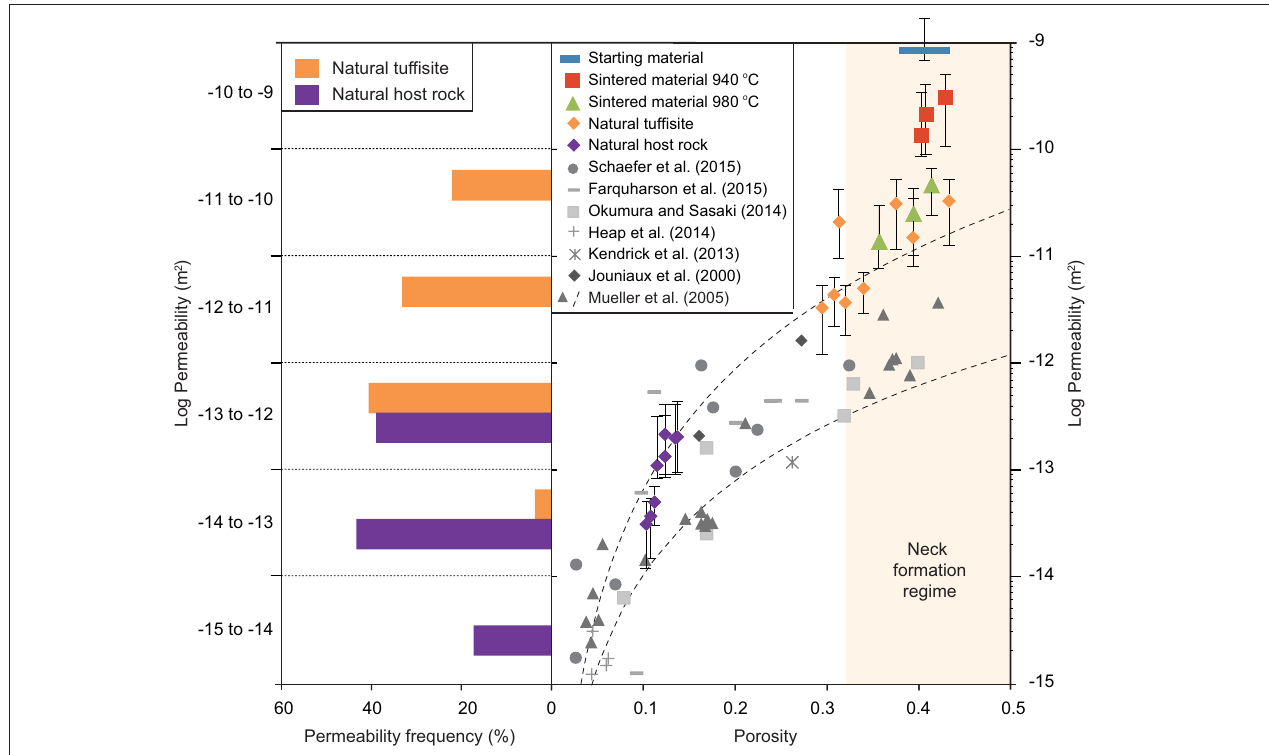
FIGURE 7 | Physical attributes of natural tuffisites, their host rocks and the crushed and sintered analogs: On the left, the permeability distribution (%) for natural materials, calculated from 23 host rock and 27 tuffisite vein permeability measurements made using the TinyPerm II minipermeameter. Following these measurements, cores of 5mm (diameter) and 3–7mm (height) were made from eight locations in the host rock and eight locations in the tuffisites to measure corresponding porosity using a He-pycnometer. All data is presented in Table 1 . On the right, this porosity and permeability relationship for the eight samples of both the natural host rock and tuffisite veins are compared to the crushed dome material and sintered tuffisite analogs from 940 to 980 ◦ C (data in Table 3 ). This is compared to porosity—permeability measurements on other lavas from Volcán de Colima (Kendrick et al., 2013; Farquharson et al., 2015) and to lavas from elsewhere ranging from basalt (Pacaya; Schaefer et al., 2015) to dacite (Mount Unzen; Mueller et al., 2005) rhyolite (Mount Meagre; Heap et al., 2014a) and in addition it is compared to the results of compaction experiments on chips of rhyolite lava (Okumura and Sasaki, 2014) and overlain by the porosity–permeability relationship for effusive lava given by Mueller et al. (2005). The plot shows the region in which the neck-formation regime is active, i.e., the region in which sintering materials plot, but where they do not follow the anticipated porosity–permeability trend for lavas. Error on permeability measurements is quoted by New England Research Inc. as < 0.2 orders of magnitude, while error on porosity is estimated to be < 0.1% for this sample size.